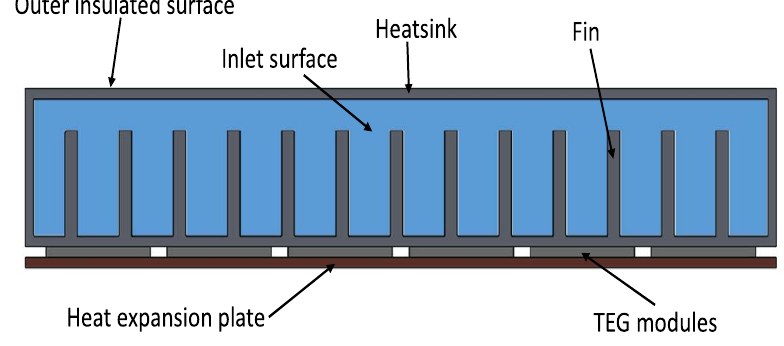
Figure 6. Front view of TEG device.